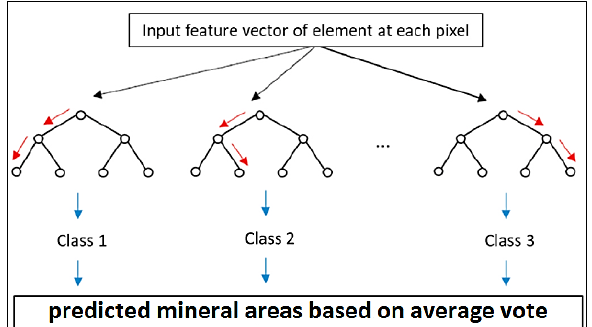
Figure 9: Illustration of the random forest for mineral